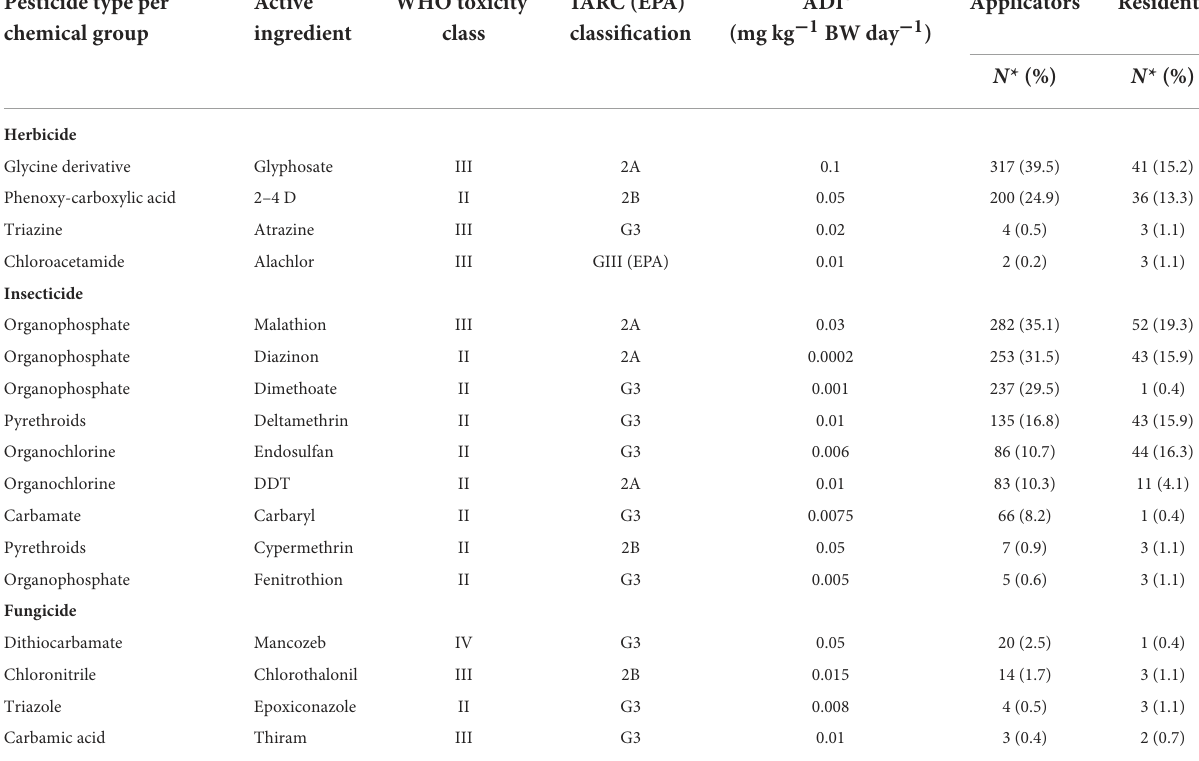
TABLE 5 Types of pesticides exposing applicators and residents in East Hararge Zone, Oromiya Region, Ethiopia. Pesticide type